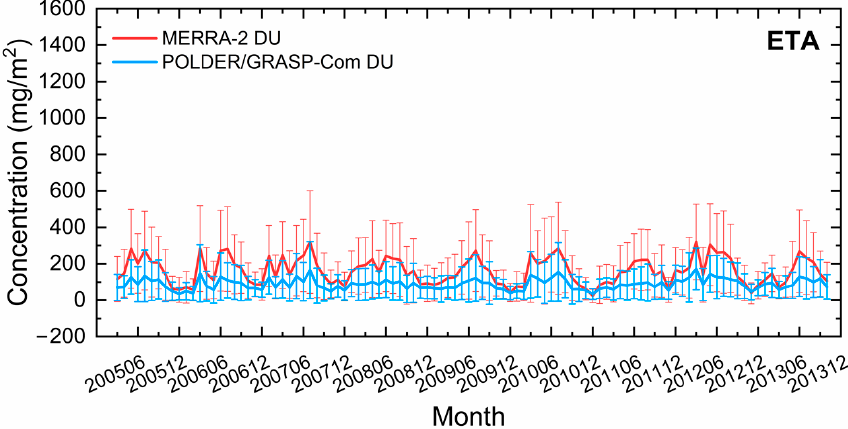
Figure 8. Same as Figure 3, but for Eastern Tropical Atlantic (ETA) region.